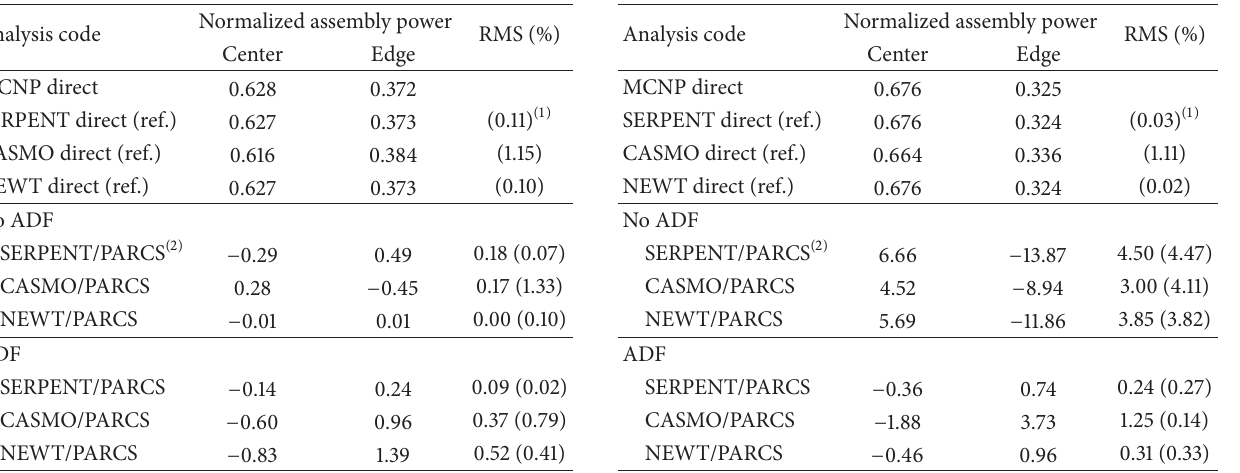
Table 9: The assembly power distribution by a direct and two-step modeling for DIMPLE S06A.